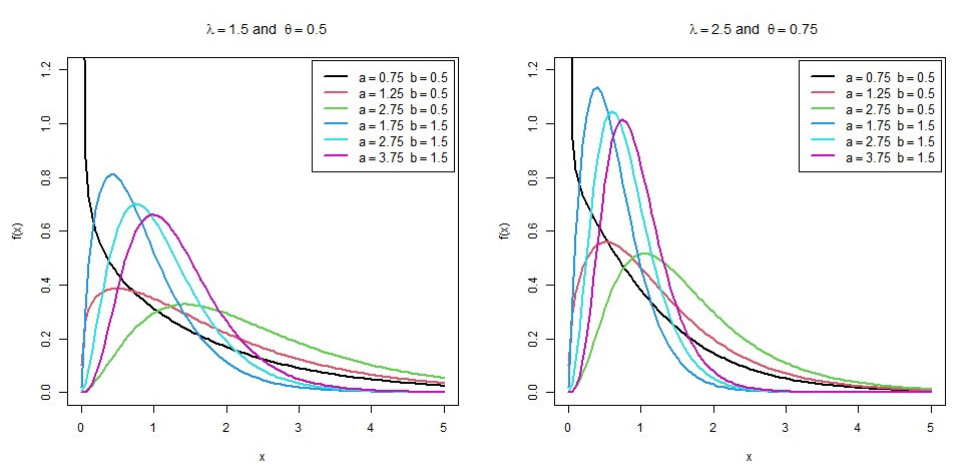
Figure 1. Plots of the pdf for the BBE 2 distribution.